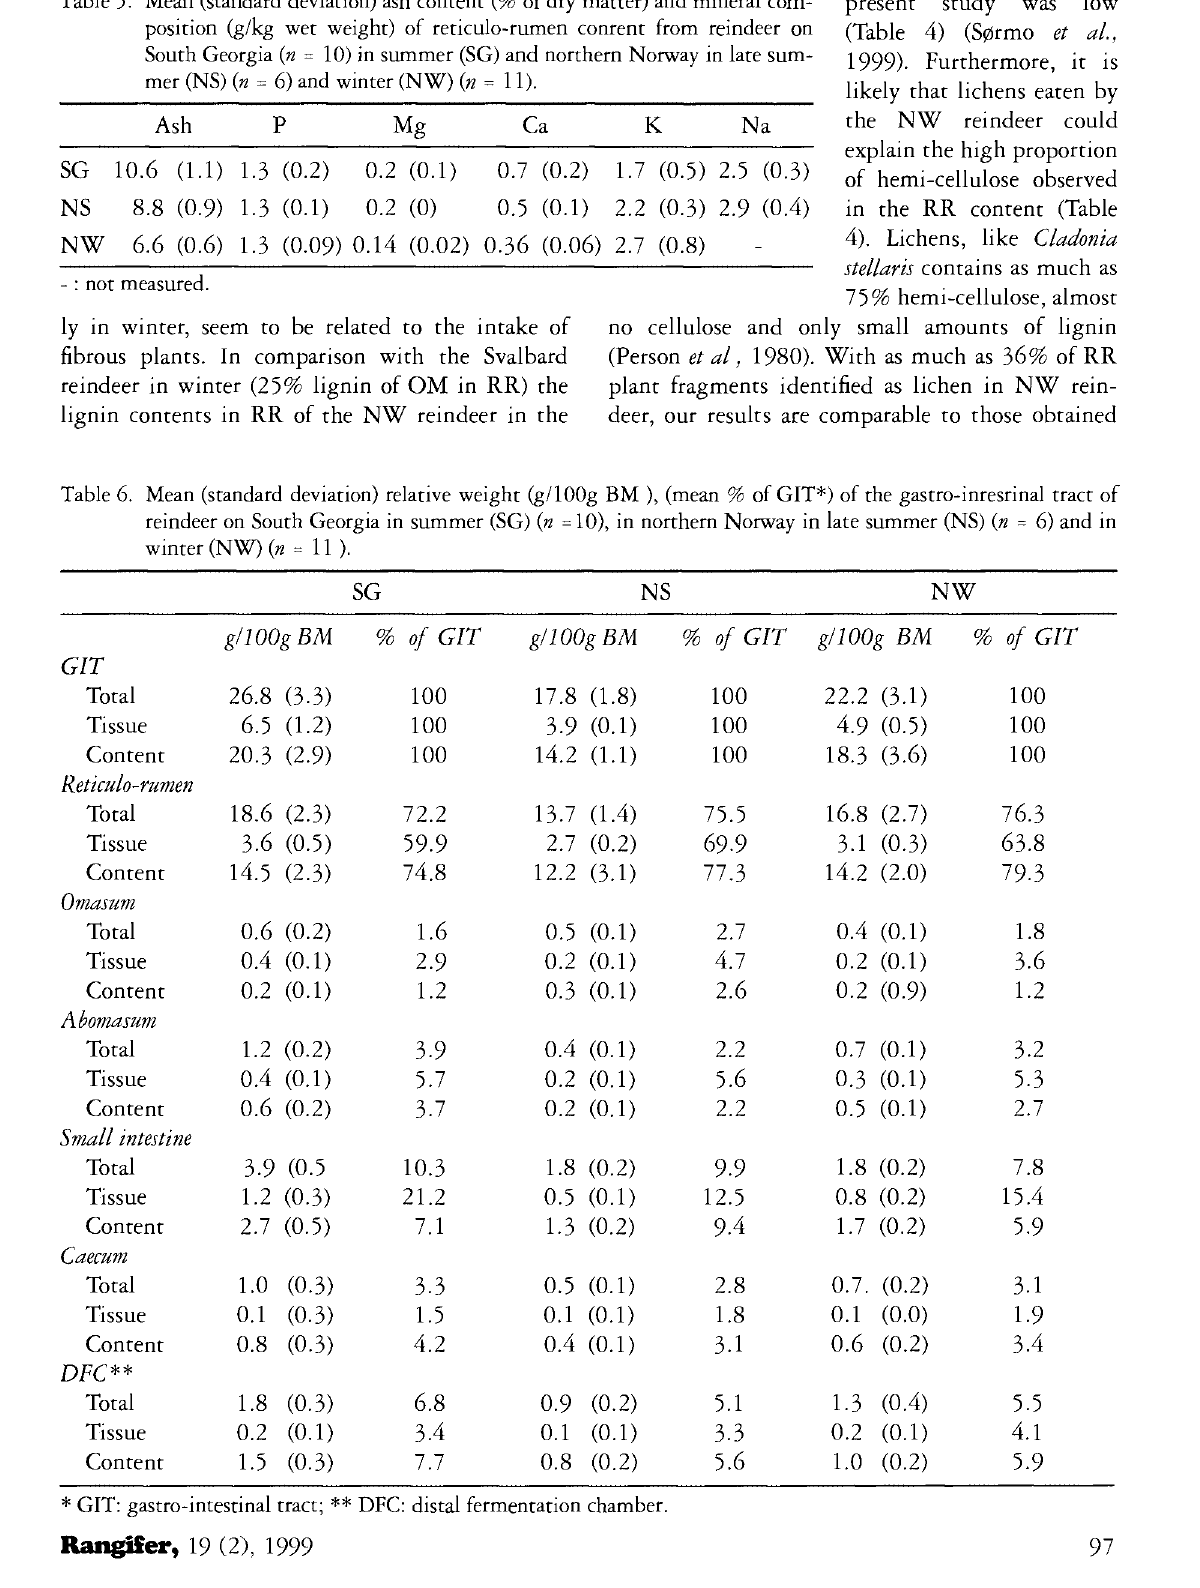
Table 6. Mean (standard deviation) relative weight (g/100g BM ), (mean % of GIT*) of the gastro-inresrinal tract of reindeer on South Georgia in summer (SG) (» = 10), in northern Norway in late summer (NS) in = 6) and in winter (NW) (n = 11